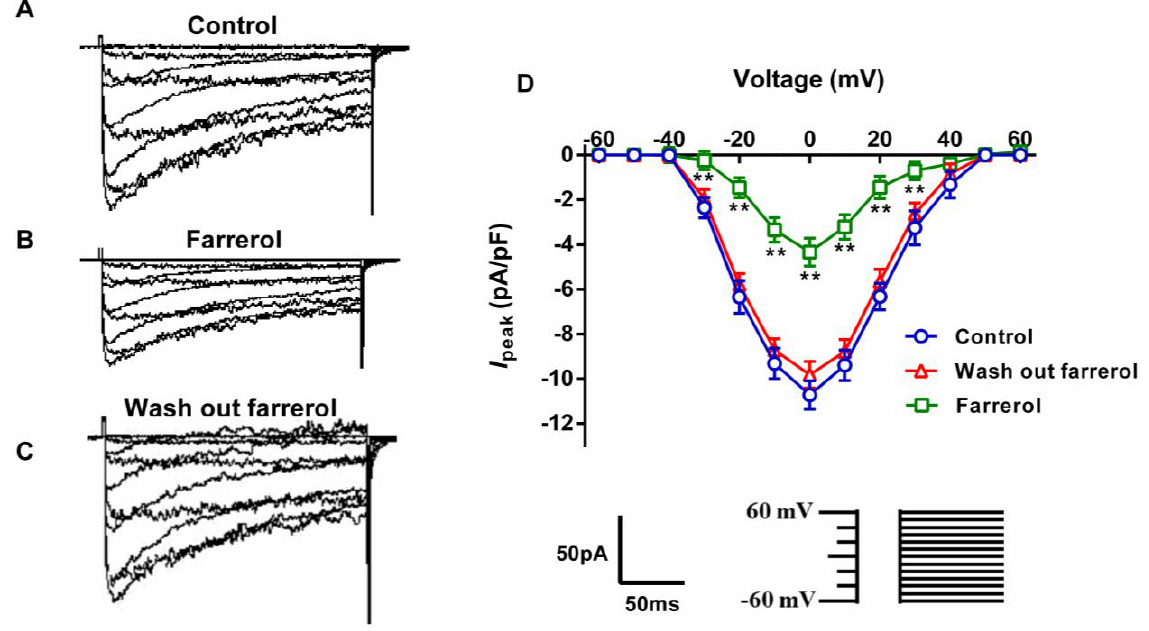
Figure 6. Effects of farrerol on the I current-voltage (I–V) curves. ( A – C ) original Ba,L tracings; ( D ) I–V relationships of the inward currents evoked by a series of depolarizing pulses (from −60 to +60 mV in 10 mV increments, duration 200 ms) in the absence (control, wash out farrerol) or the presence of farrerol (14.02 μM), respectively. Data are expressed as mean ± SD from VSMCs isolated from 8 rats. ** p < 0.01, vs .